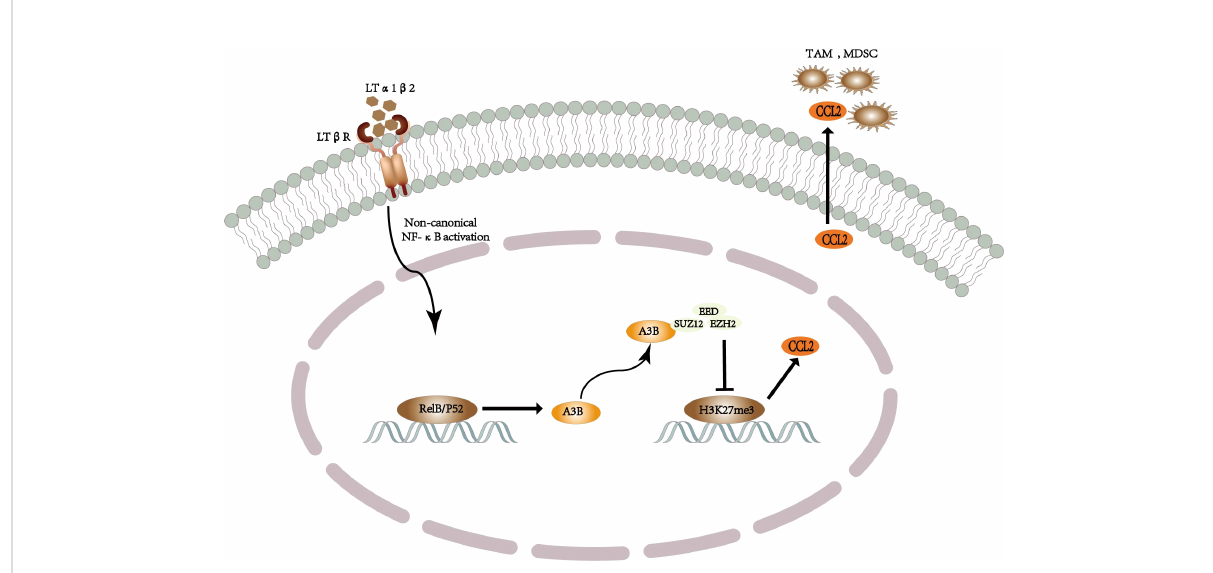
FIGURE 3 Schematic diagram of the mechanism by which APOBEC3B-driven TAM and MDSC recruit to promote the development of liver